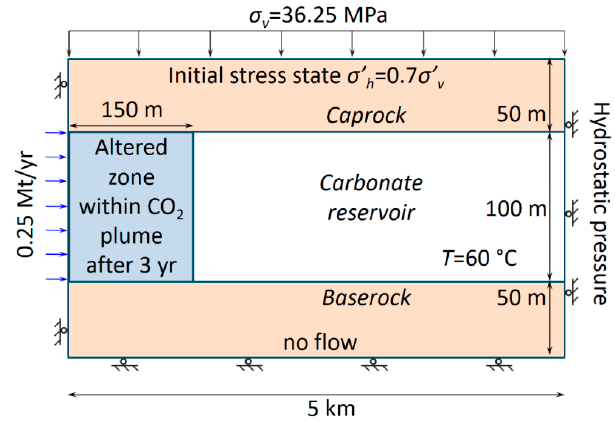
Figure 1. Schematic representation of the model geometry and boundary and initial conditions.